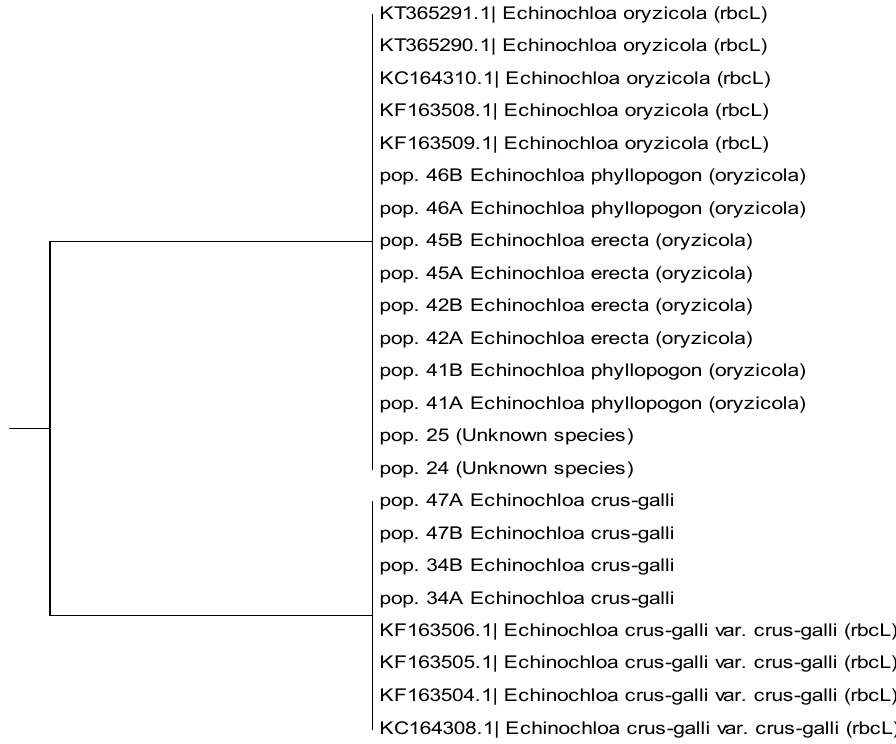
Figure 1. Cladogram obtained from UPMGA estimation of nine Echinochloa rbcL sequences from GenBank database (identified by GenBank ID, e.g., KT365291.1) and 14 sequences from seven previously identified accessions (e.g., 41A and 41B are two plants derived from seeds of the same mother plant) harvested in Italian rice fields.